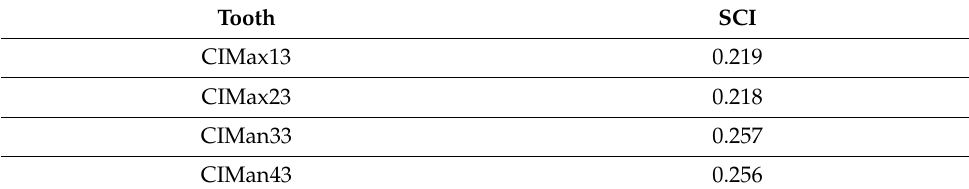
Table 8. Standard canine index of permanent canines in maxillary and mandibular arch.